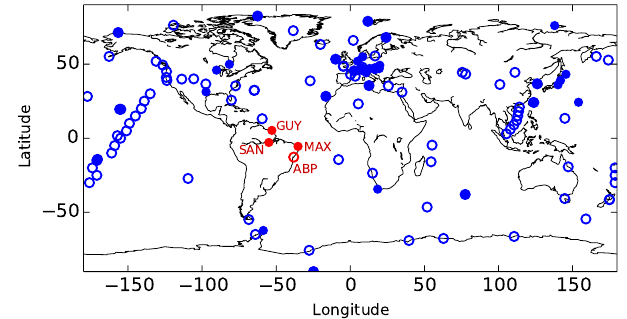
Figure 1. Location of the surface stations used in this study. Blue indicates surface stations used in MACCv10.1; red shows the sur- face stations in South America added to the previous setup of MACCv10.1. Filled circles are stations with continuous measure- ments; open circles are sites with discrete air